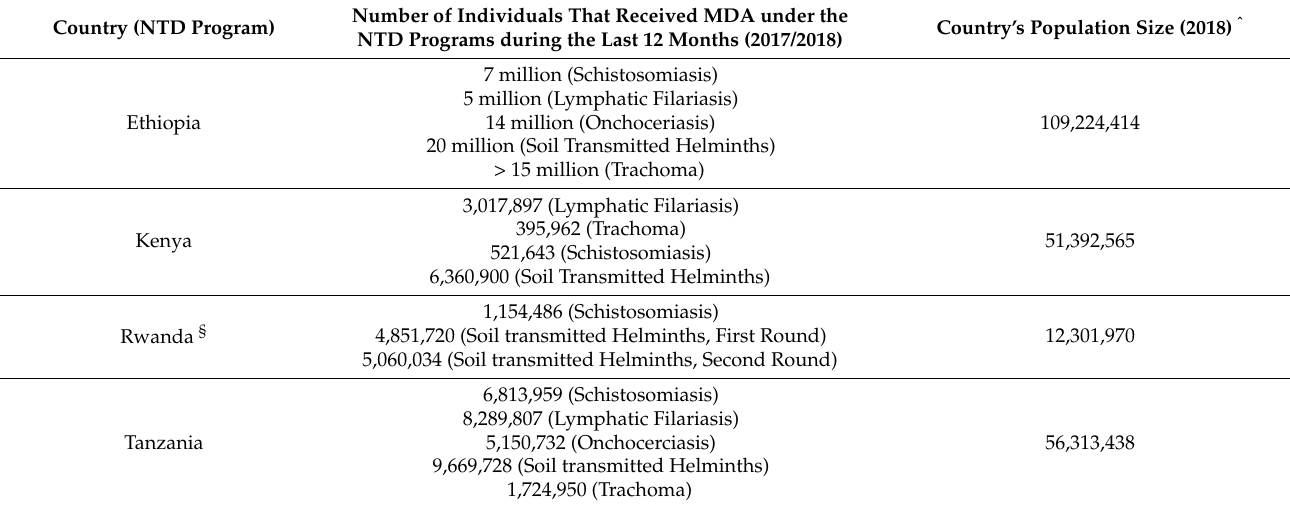
MDA, mass drug administration. ˆ The population size for each country was taken from Worldometers [24]. § In Rwanda, the NTD program carried out MDA only for schistosomiasis and soil transmitted helminths, and MDA for soil transmitted helminths was carried out